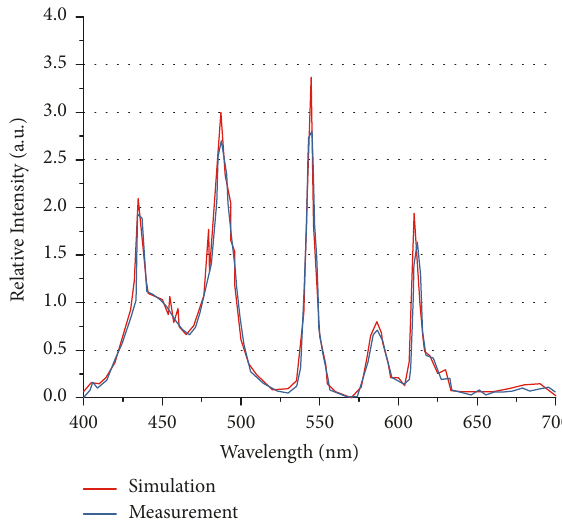
Figure 5: Output spectra of measurement and simulation of LCD module in the dark